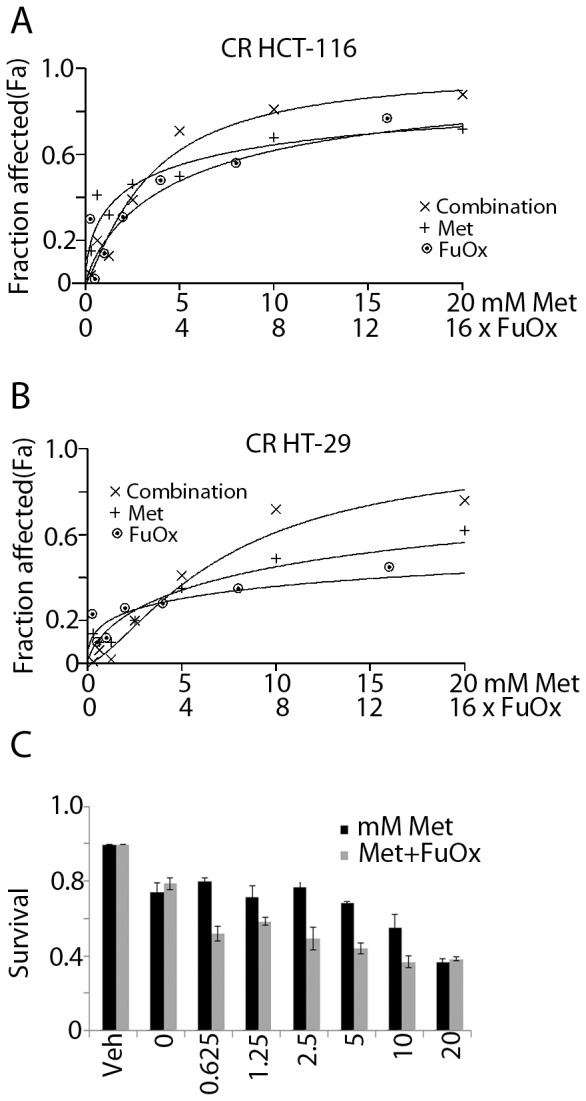
A&B Dose response curves for metformin and/or FuOx in CR HCT-116(A) and CR HT-29 (B) cells produced by fixed ratio method. Fraction of cells affected by combination of the two drugs (fixed ratio) was higher than either agent alone. Fa represents the fraction of cells affected in response to the treatment. Fa values were used to conduct synergy analysis by CalcuSyn software as described in Materials and Methods. C. Relative survival of CR HT-29 cells in the presence of increasing doses of metformin with and without 2×FuOx. Combination treatment is more effective at all the concentrations. Veh: vehicle alone. Each treatment was performed in quadruplicates, bars represent mean ± standard deviation. * p value<0.05.